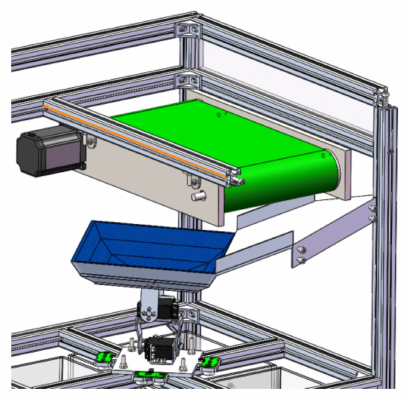
Figure 2. 3D model of the waste separation mechanism and the sorting